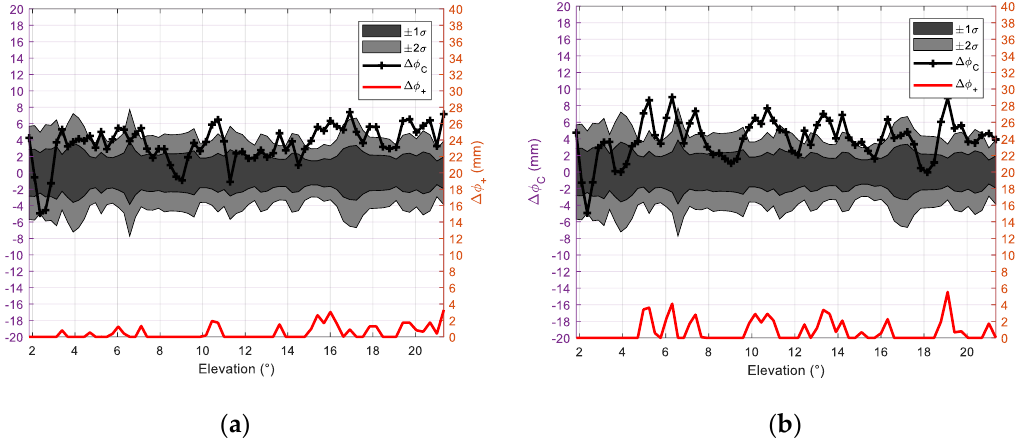
Figure 6. Examples of phase shift from two rainy days: ( a ) on 6 July 2015; ( b ) on 10 August 2015.